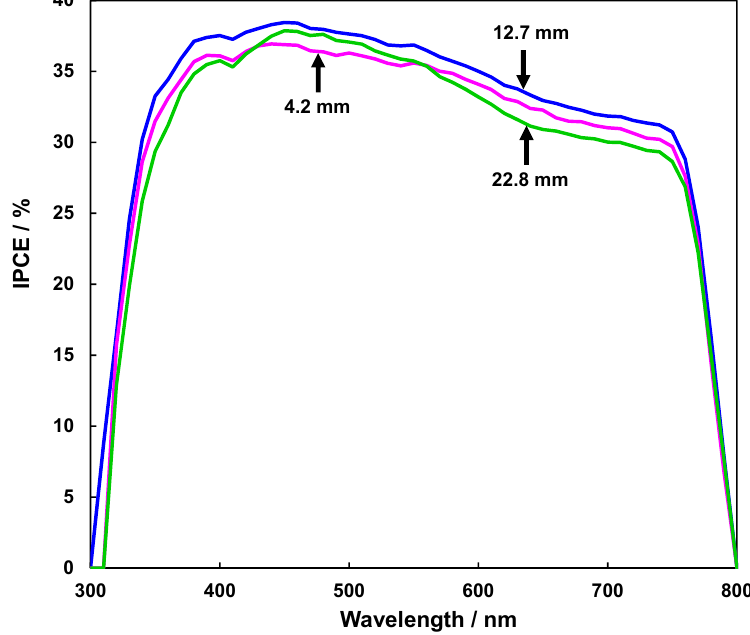
Figure 5. Incident photon to current conversion efficiency spectra of the TiO 2 /CH 3 NH 3 PbI 3